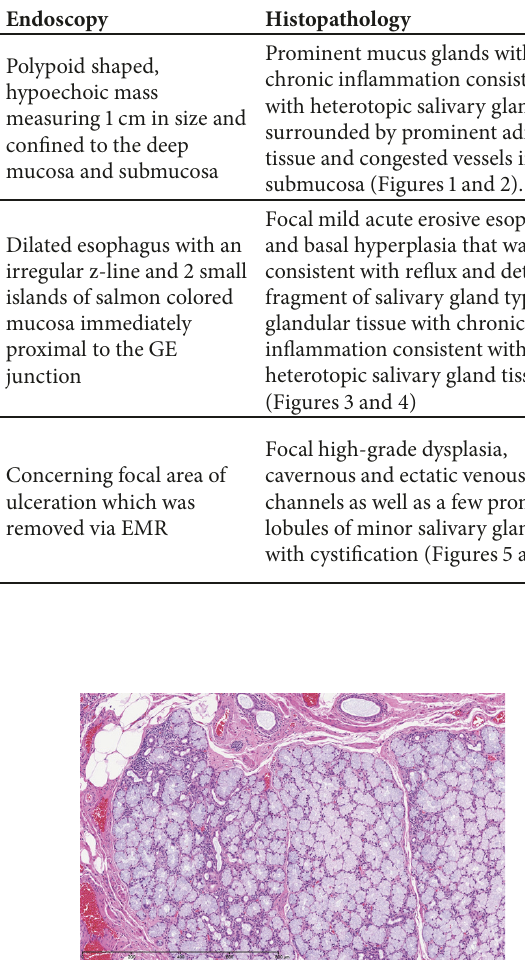
Figure 1: Low-magnification appearance of the heterotopic sali- vary glands demonstrating their submucosal location surrounded by prominent adipose tissue and congested vessels. This case is classified as a salivary gland choristoma since the heterotopic tissue formed a mass.